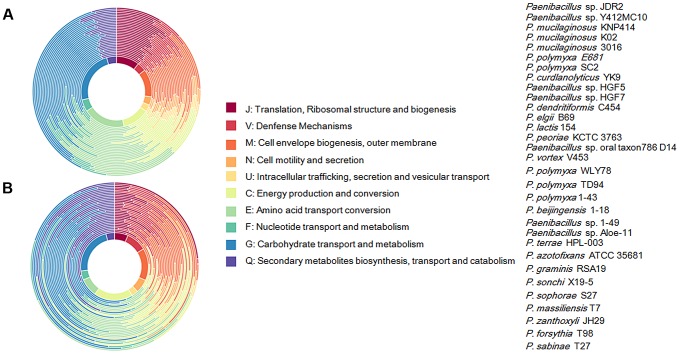
Functional classification of gene content of the 31 Paenibacillus strains.(A) Profiles of Cluster of Orthologous Groups (COG) showing percentage of genes in each category out of total annotated genes. Taxa from inside of circle to outside of circle are from Paenibacillus sp. JDR 2 (top in the strain list) to P. sabinae T27 (down in the strain list). (B) Profiles of COG showing function categories for genes in core genomes. Taxa from inside of circle to outside of circle are from Paenibacillus sp. JDR 2 (top in the strain list) to P. sabinae T27 (down in the strain list).